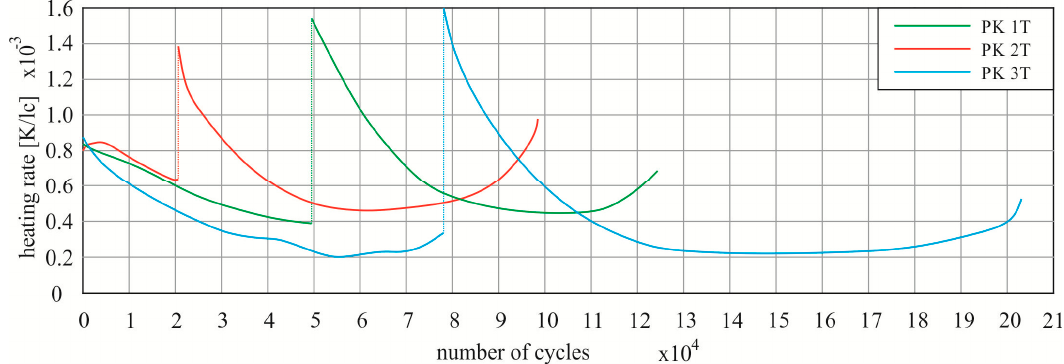
Figure 9. Heating rate for the first and second fatigue load inside the specimen.